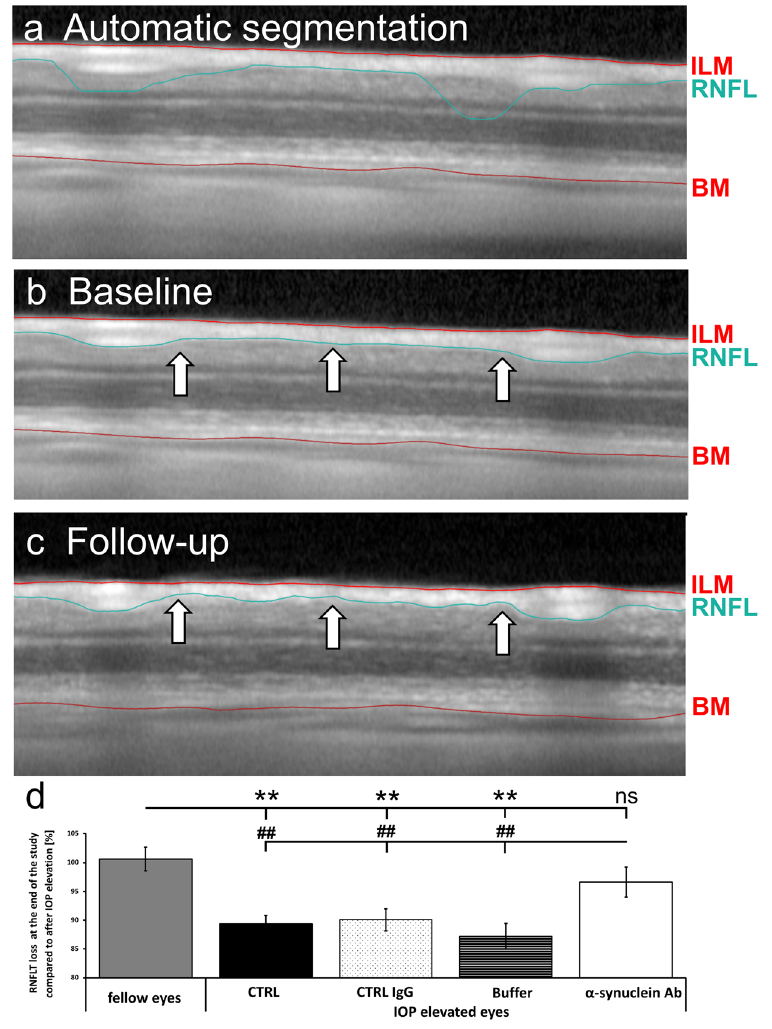
Figure 2. Optical coherence tomography enables circular scans of the retina to detect changes of the retinal nerve fibre thickness. The optical coherence tomography (OCT) enables cross-sectional images of the retina in vivo to gather longitudinal information about changes of the retinal nerve fiber layer thickness (RNFLT). RNFLT was defined as the distance between the inner limiting membrane (ILM, red line) and the retinal nerve fiber layer (RNFL, green line). For orientation, the basal membrane (BM, lower red line), indicating the border to the retinal pigment epithelium, is shown. ( a ) Using the Heidelberg Eye Explorer software, the native segmentation algorithm designed to identify specific layers of the human retina, was not always suitable for rodent retina. The RNFL needed manual correction with the circle device. ( b ) The baseline measurement of a CTRL animal. ( c ) The follow-up of the same eye at the end of the study shows distinct changes of the RNFLT as indicated by arrows. ( d ) The loss of RNFLT at the end of the study was compared with after IOP elevation. Fellow eyes were not affected. IOP elevated eyes of CTRL, CTRL IgG and Buffer group showed a significant loss, while damage was less severe in α -synuclein Ab group. With respect to α -synuclein Ab group, RNFLT was significantly higher than in CTRL, CTRL IgG and Buffer groups. ** Represents p < 0.01 compared with fellow eyes. ## Represents p < 0.01 compared with IOP elevated eyes of α -synuclein Ab group. ns = not